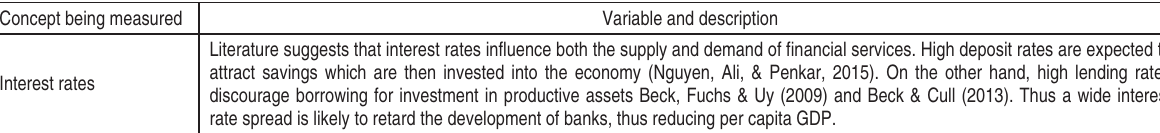
Table 1 (cont.). Description of control